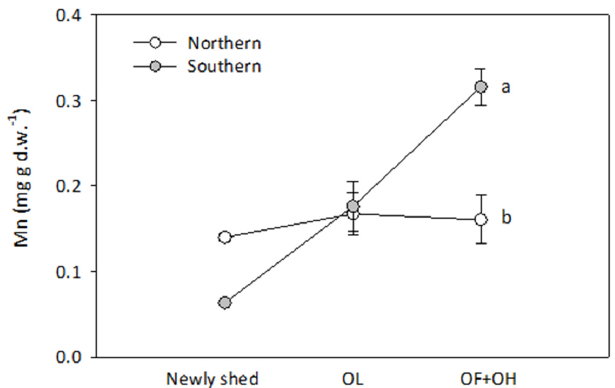
Figure 2. Mn concentrations in newly ‐ shed leaves and floor litter in a northern and a southern beech forest. Values for newly ‐ shed litter are means ± standard error; n = 9. Values for forest floor are means ± standard error; n = 36 (6 sampling plots, 2 sampling seasons, 3 replicate analyses); different lower ‐ case letters indicate significant differences between sites ( t ‐ test; overall significance level = 0.05).